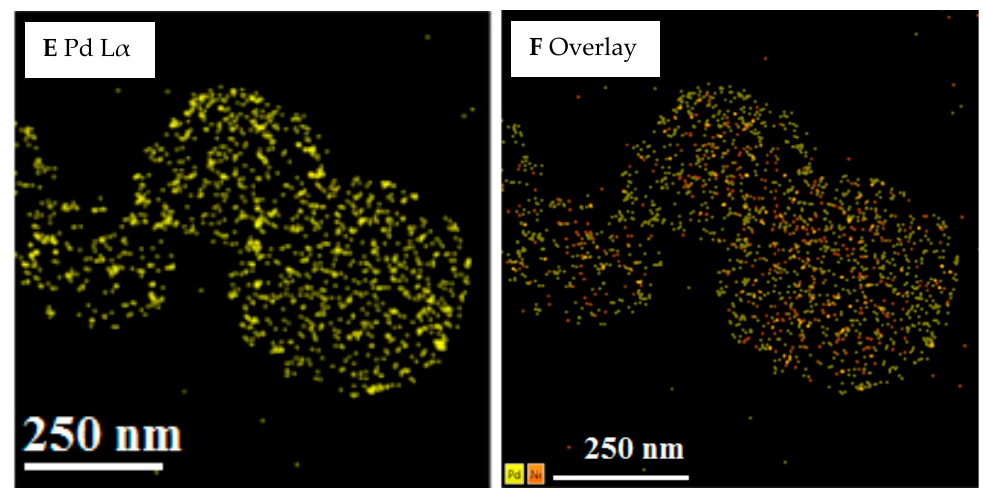
Figure 2. ( A ) TEM image, ( B ) PdNi size distribution, ( C ) STEM-HAADF image, and ( D – F ) EDS elemental mapping images of PdNi/UiO-66 (1:1).